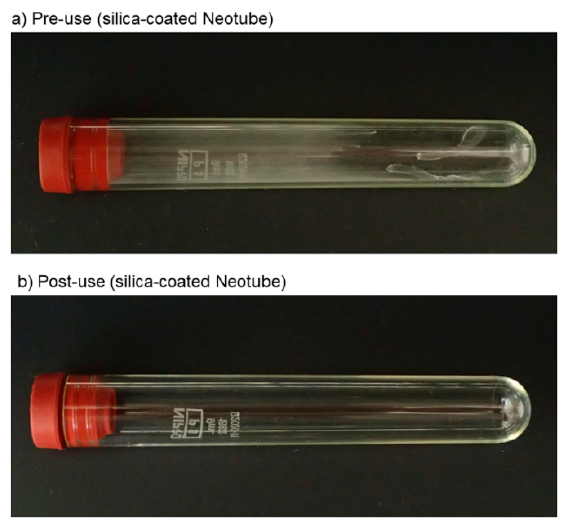
Figure 1. Macroscopic appearance of the silica-coated plastic tube (Neotube) pre- ( a ) and post-centrifugation ( b ).